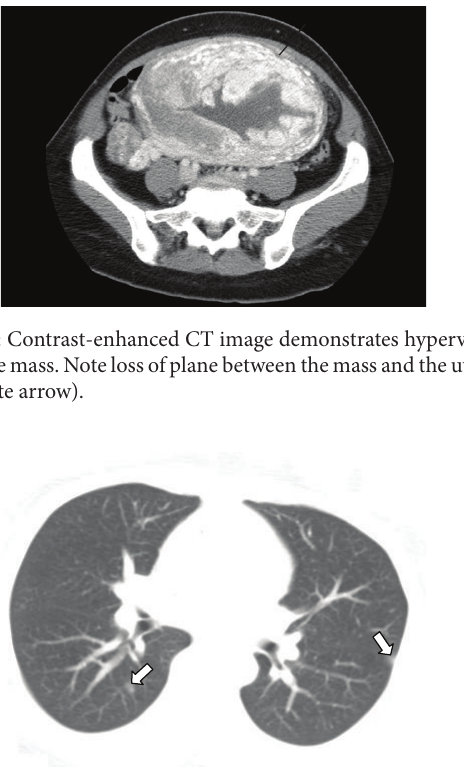
Figure4:CTimageofthechestdemonstratesgroundglassopacities in the lungs (open